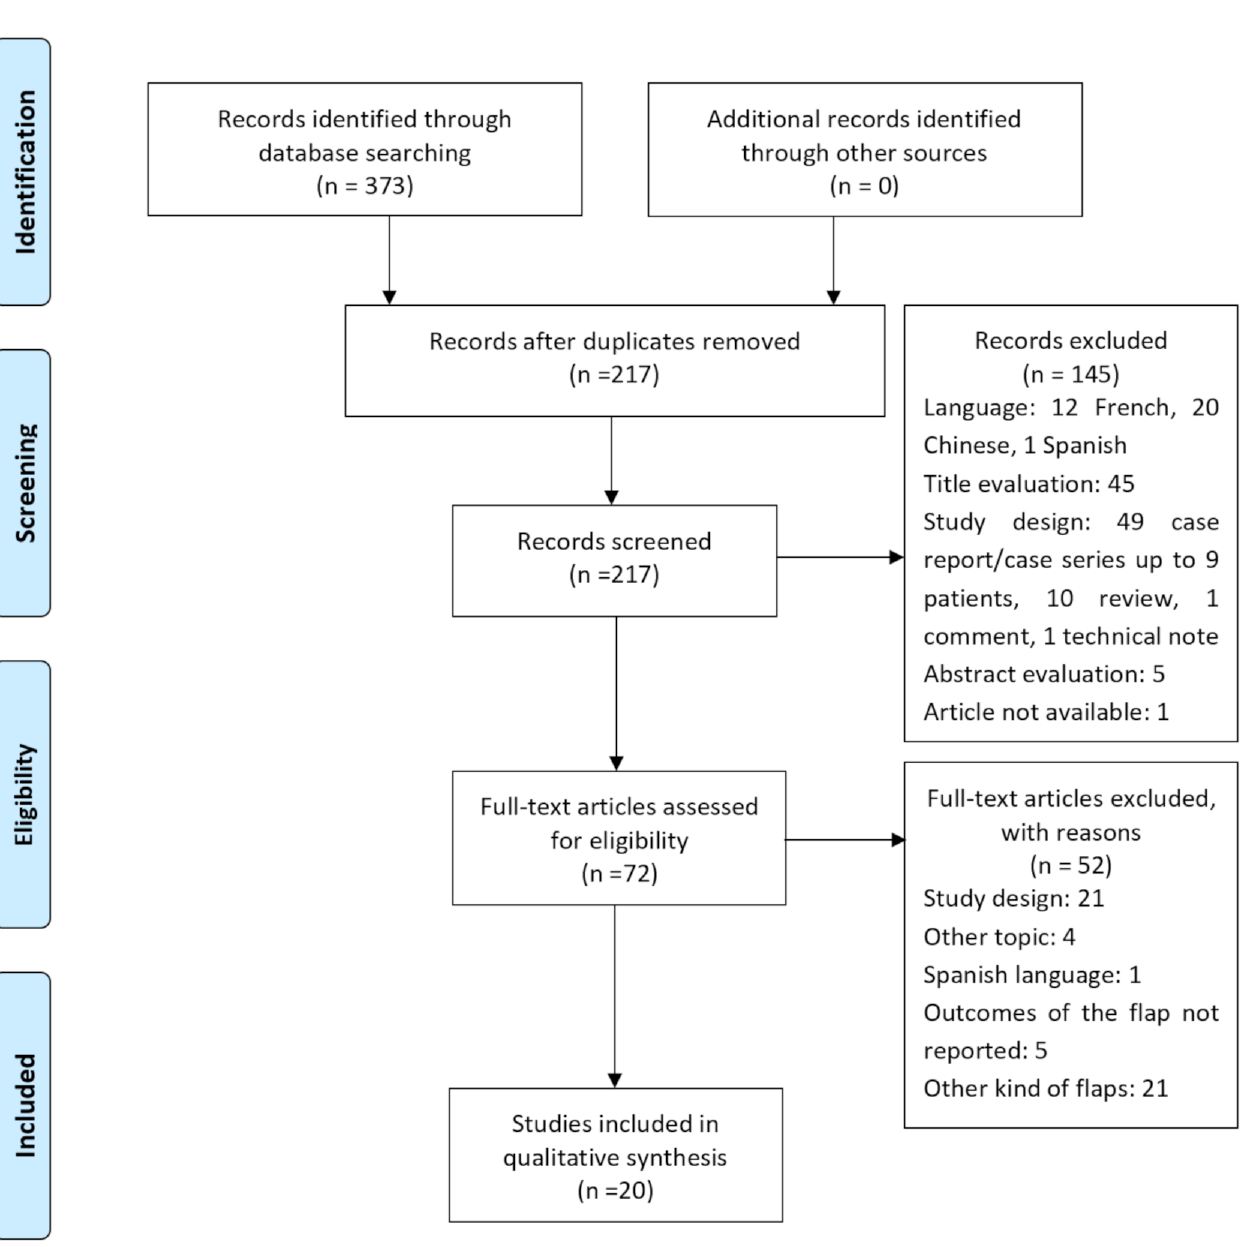
Figure 1. Flow diagram of literature search and study